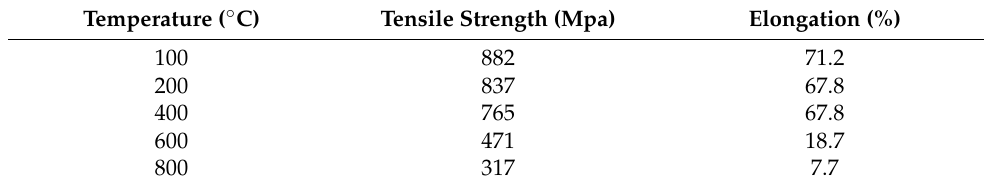
Figure 1. Quasi-static tensile properties of Ni48W35Co17 alloy at different temperatures, ( a ) the tensile strength; ( b ) the elongation. Table 1. Quasi-static tensile properties of Ni48W35Co17 alloy at different